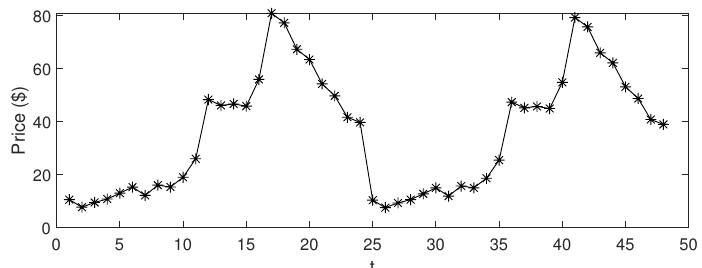
Figure 4. Hourly forecasted electricity market